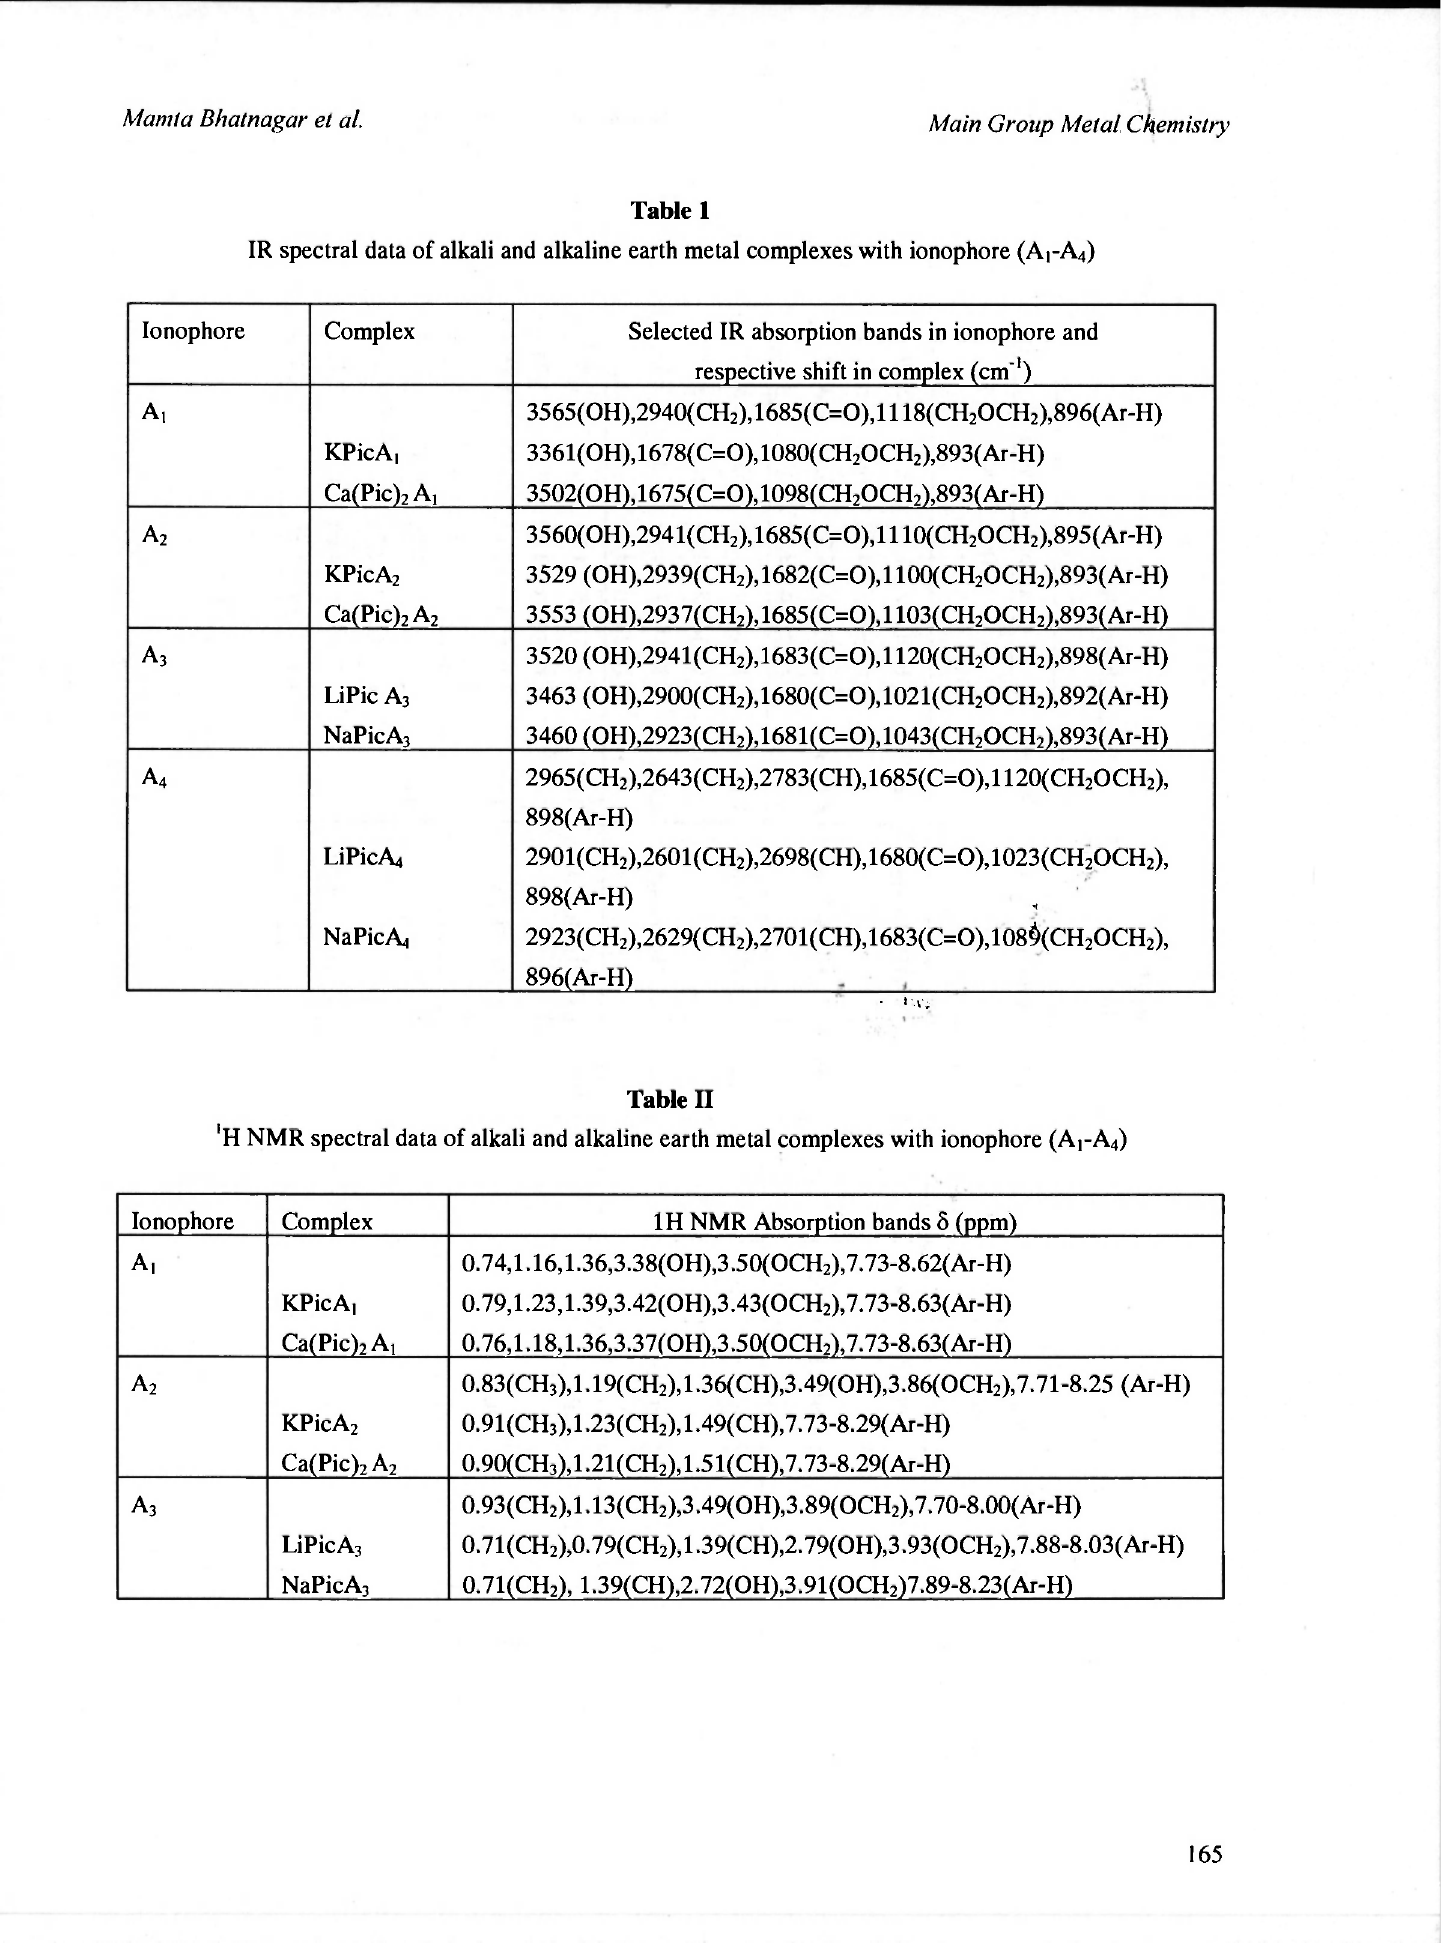
IR spectral data of alkali and alkaline earth metal complexes with ionophore (A r A 4 )